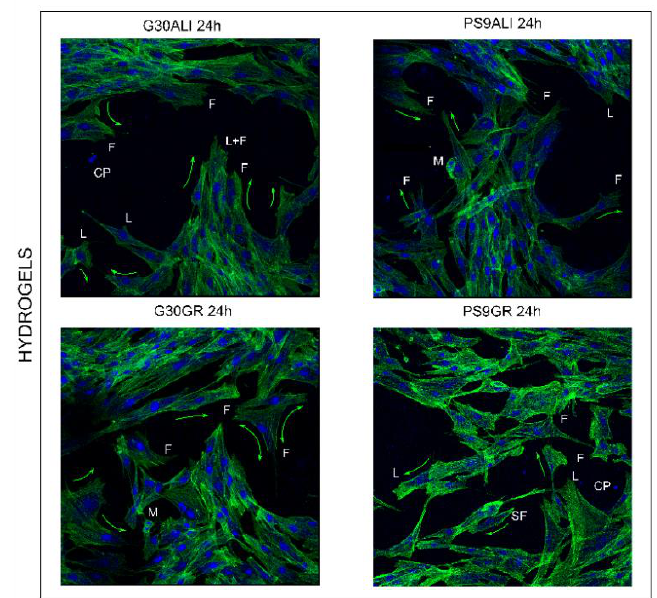
Figure 9. CLSM microphotographs during wound healing. NHDMs were stained with phalloidin-FITC (green, F-actin filaments) and DAPI (blue, nucleus). Green arrows indicate the migration direction; different F-actin structures have been identified by L (lamellipodia), F (filopodia), SF (stress fibers) and DSF (dorsal stress fibers). Additionally, M stands for (mitosis) and CP stands for (clay particles).